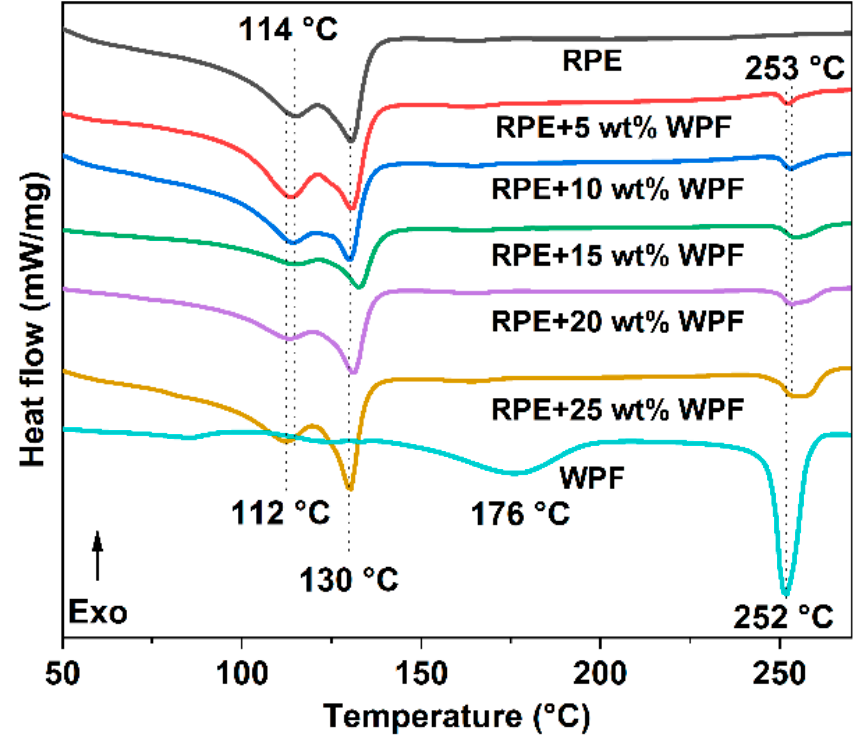
Figure 3. DSC curves of RPE, WPF and RPE/WPF composites with different WPF contents.